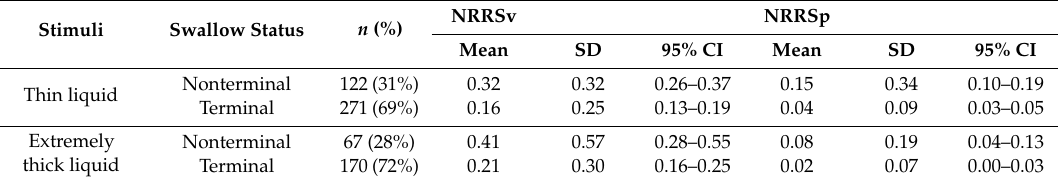
Table 2. Distribution of Normalized Residue Ratio Scale (NRRS) scores for the valleculae (NRRSv) and pyriform sinus (NRRSp) by nonterminal versus terminal swallow within the swallow